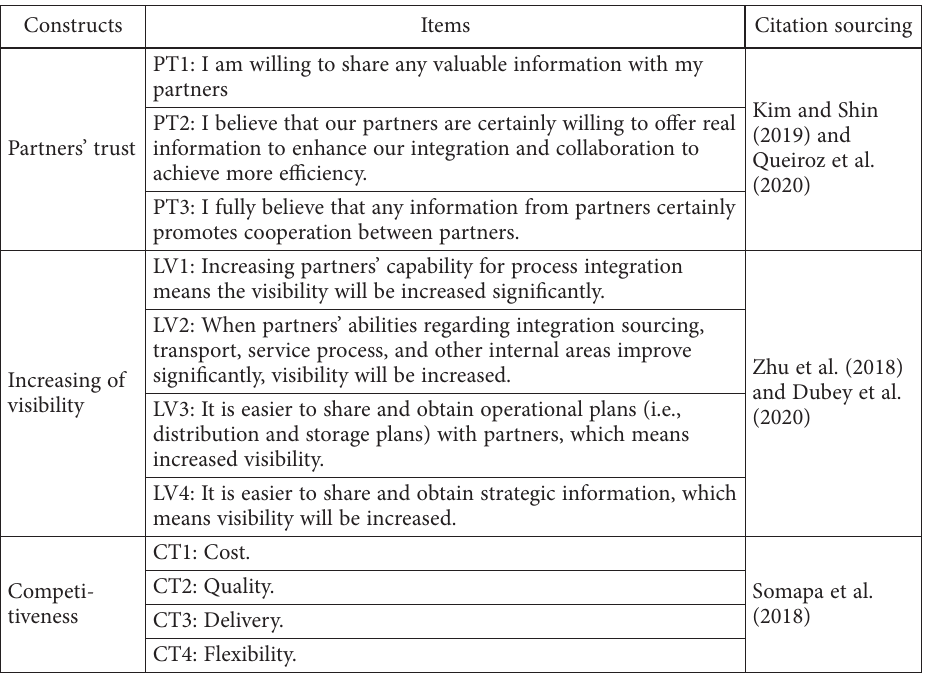
Table 1. Constructions and items, and citation